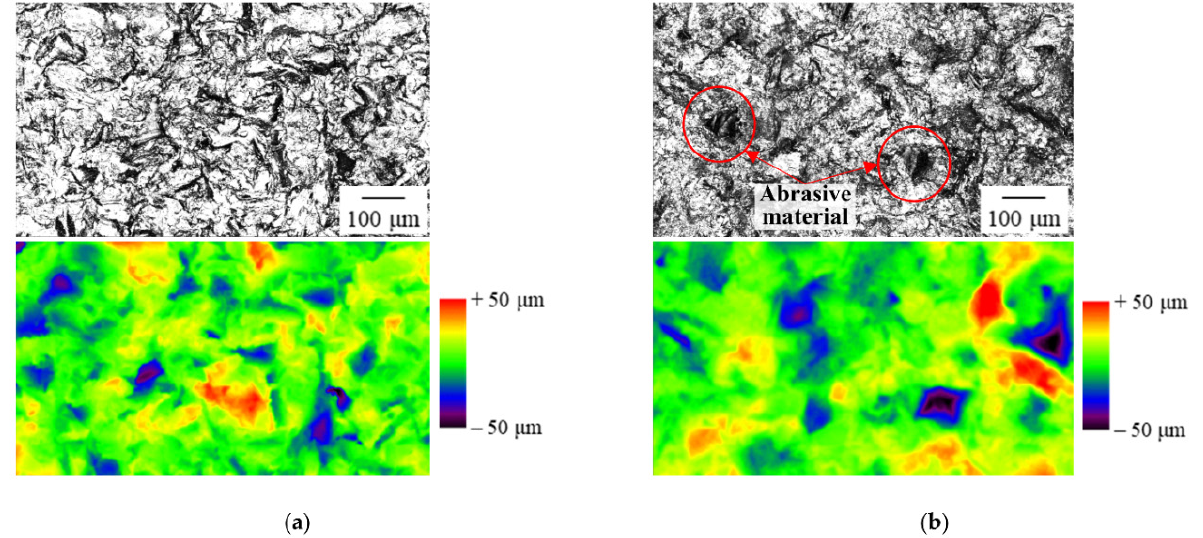
Figure 2. Blasted surface and color scale according to roughness measured by a laser microscope: ( a ) MST, ( b ) MAL.